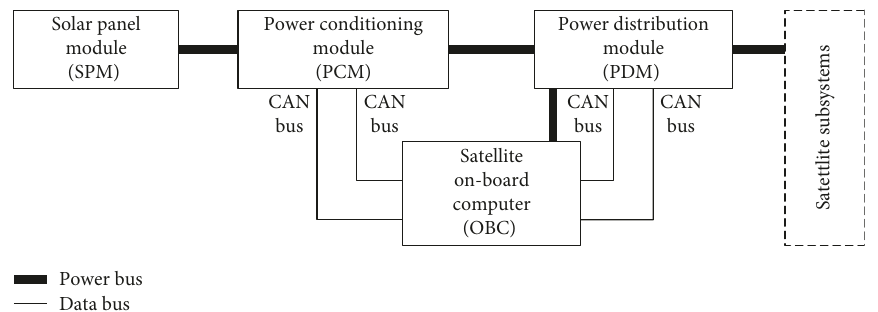
Figure 1: Block diagram of EPS